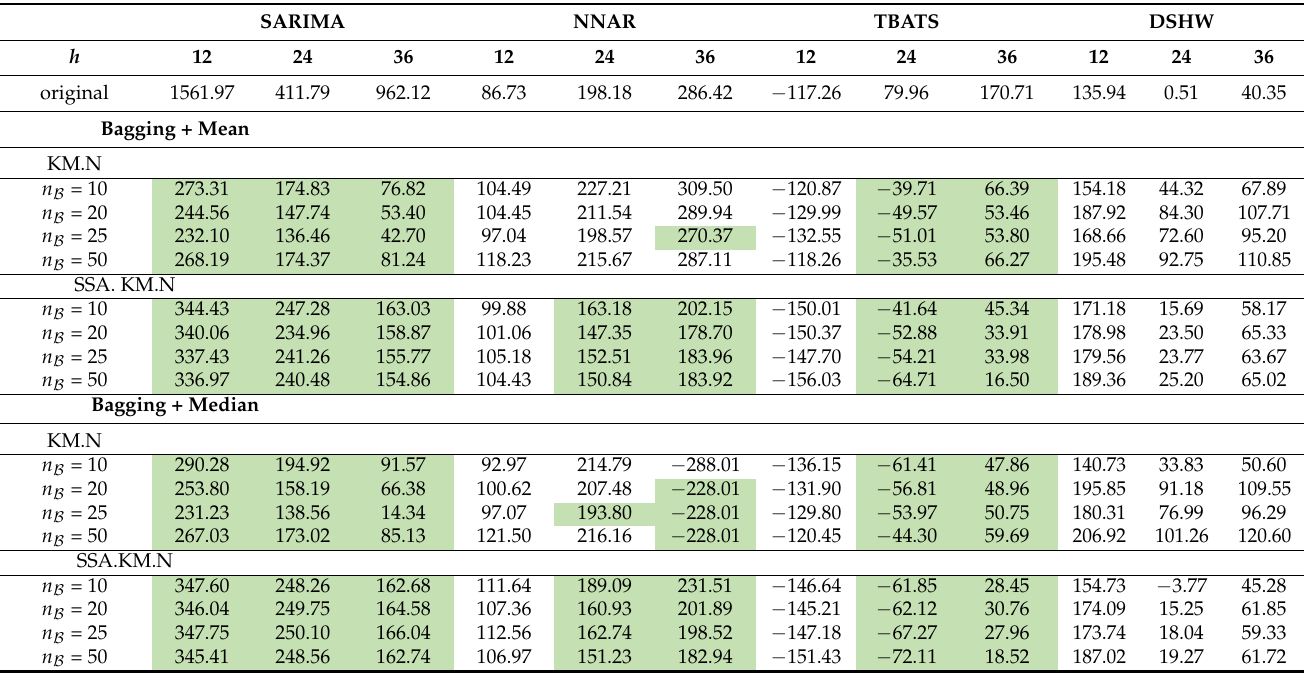
Green cells represent the MBE values obtained from the bootstrap series for the Polish data set lower (in absolute values) than those obtained from the original